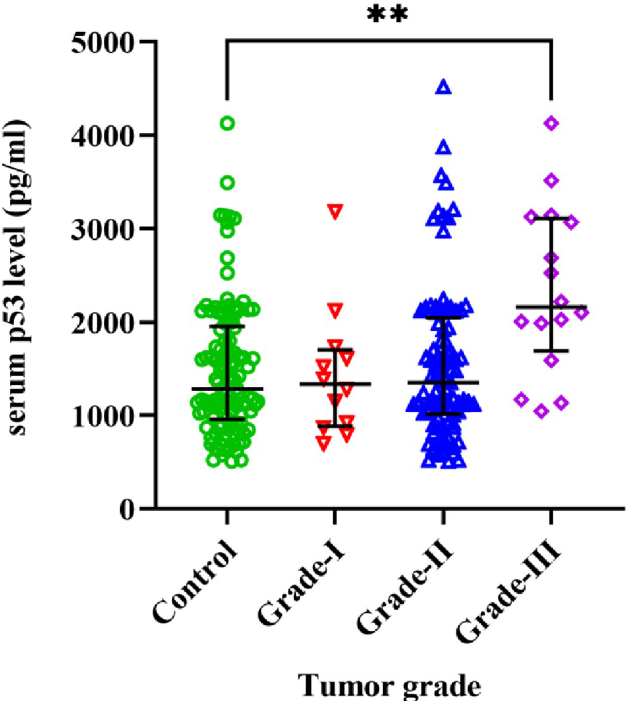
Fig 2. Differences in serum p53 expression between controls vs cases with different grades of tumor (Kruskal- Wallis, H = 11.19, P = 0.004). Level of p53 expression: [(controls: 1285 pg/ml, IQR: 957.8–1953); (cases with grade-I tumor: 1216 pg/ml, IQR: 812.3–1588); (cases with grade-II tumor: 1204 pg/ml, IQR: 921–1796); (cases with grade-III tumor: 2064 pg/ml, IQR: 1275–2974)]. Control vs grade-I tumor (mean rank difference: 2.882, adjusted P > 0.99); control vs grade-II (mean rank difference: − 2.836, adjusted P > 0.99); control vs grade-III (mean rank difference: -69.13, adjusted P = 0.001). Error bars represent median ± interquartile range. �� P < 0.01.